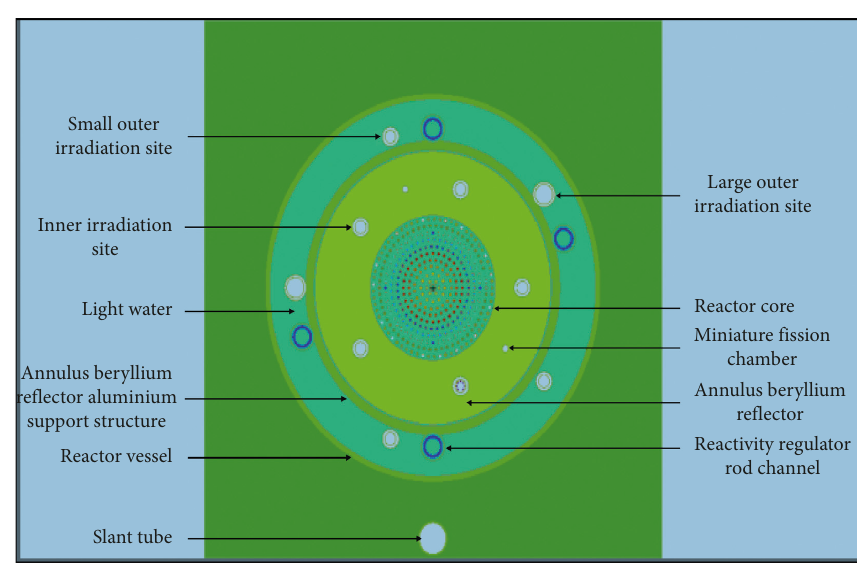
Figure 2: Core configuration of the GHARR-1 reactor